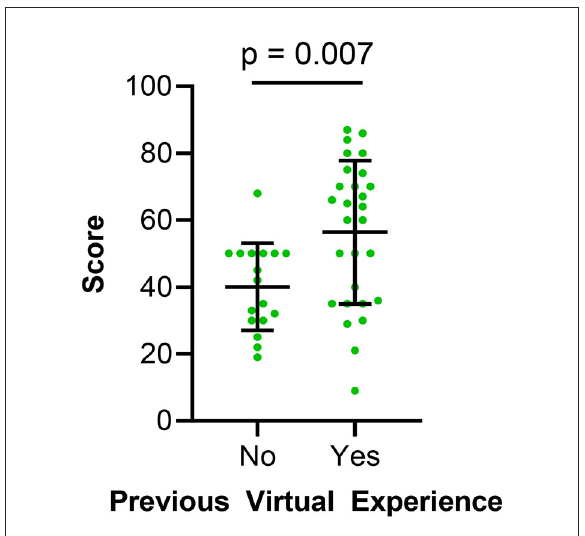
FIGURE5 Individual scores from the post-conference survey addressing expectation based on previous virtual conference experience. Error bars represent standard errors of mean.